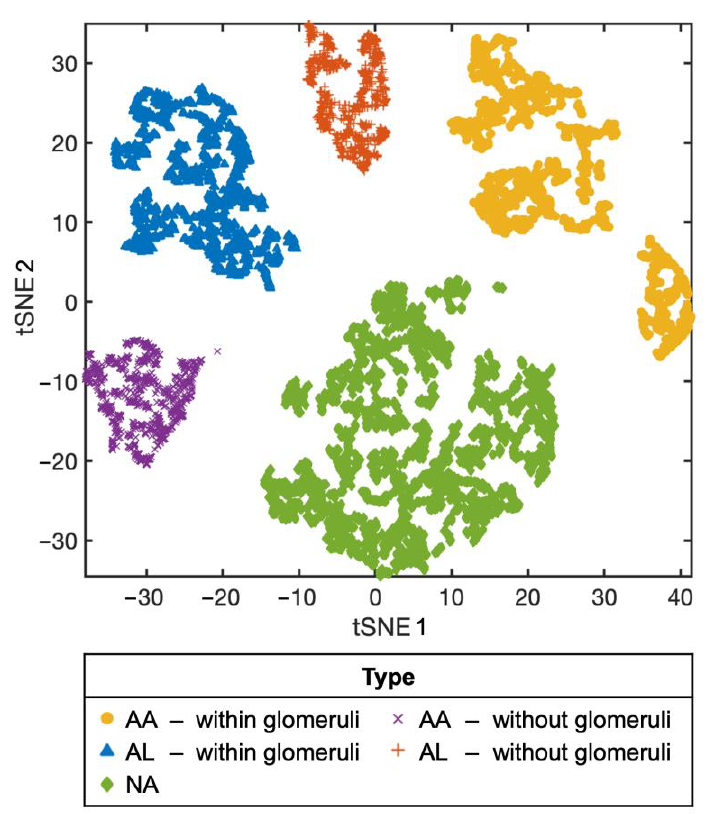
Figure 5. t-SNE map for the distribution of Raman spectra. Spectra were identified with their amyloid types (AA, AL, or NA) and location (within or without glomeruli). Each point represents a Raman spectrum that is positioned based on the similarity probability of the spectra in the dataset. Each group is well separated from other groups, indicating that the Raman spectra of the same group are similar and distinct from those of other groups.